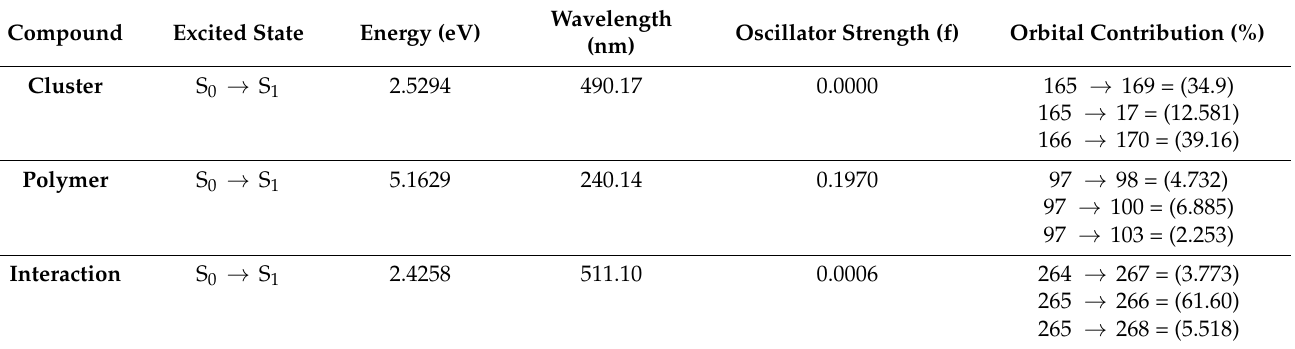
Table 4. Absorption energies, wavelengths (nm), and major contributions with oscillator strength